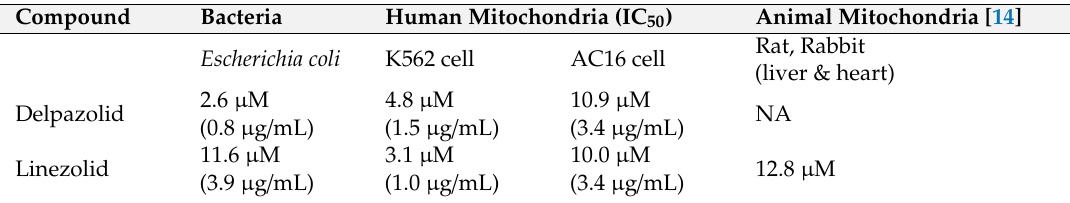
Table 2. Antibiotic properties of oxazolidinones on bacterial and mitochondrial protein synthesis.